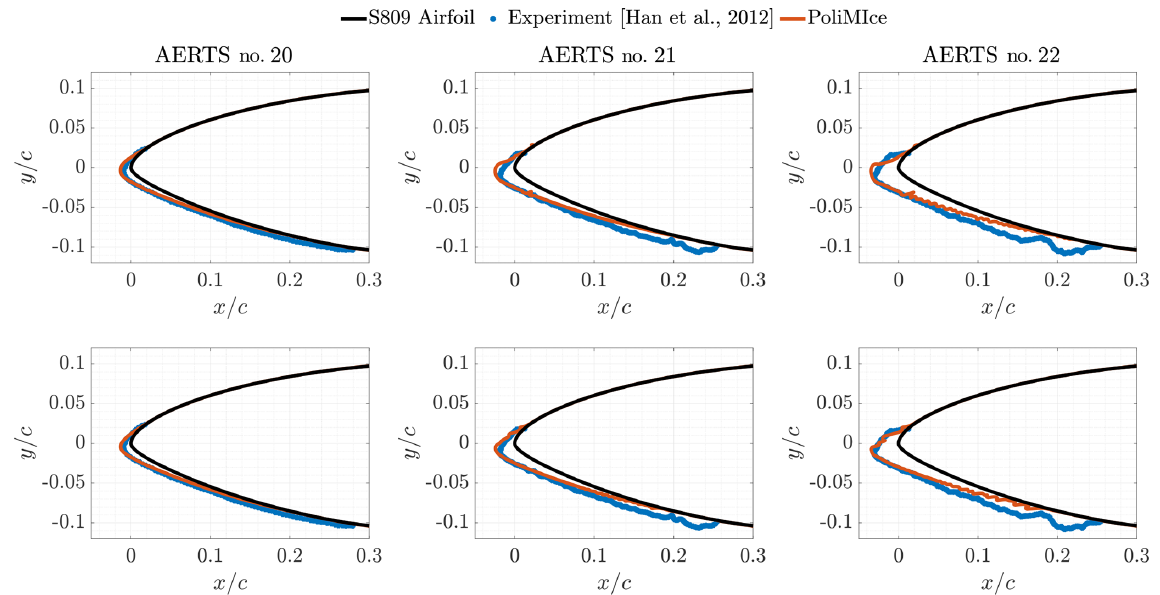
Figure 12. PoliMIce simulations of three AERTS test cases. Each column represents the same test case. The three test cases have the same atmospheric conditions and only differ in total ice accretion time (left: 30min; centre: 60min; right: 90min). In each row the same numerical set-up is used for the multi-step ice accretion (top: (cid:49)t = 15min, (cid:107) err β (cid:107) 2 < 3 × 10 − 6 ; bottom: (cid:49)t = 3min, (cid:107) err β (cid:107) 2 < 3 × 10 − 5 ).